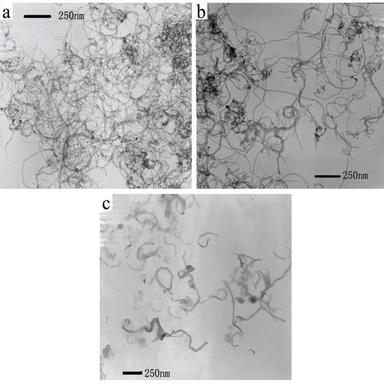
TEM of P3HT-MWCNT prepared by click chemistry: (a) MWCNT; (b) P3HT/MWCNT physical blends (10: 1, by wt); (c) P3HT-MWCNT.